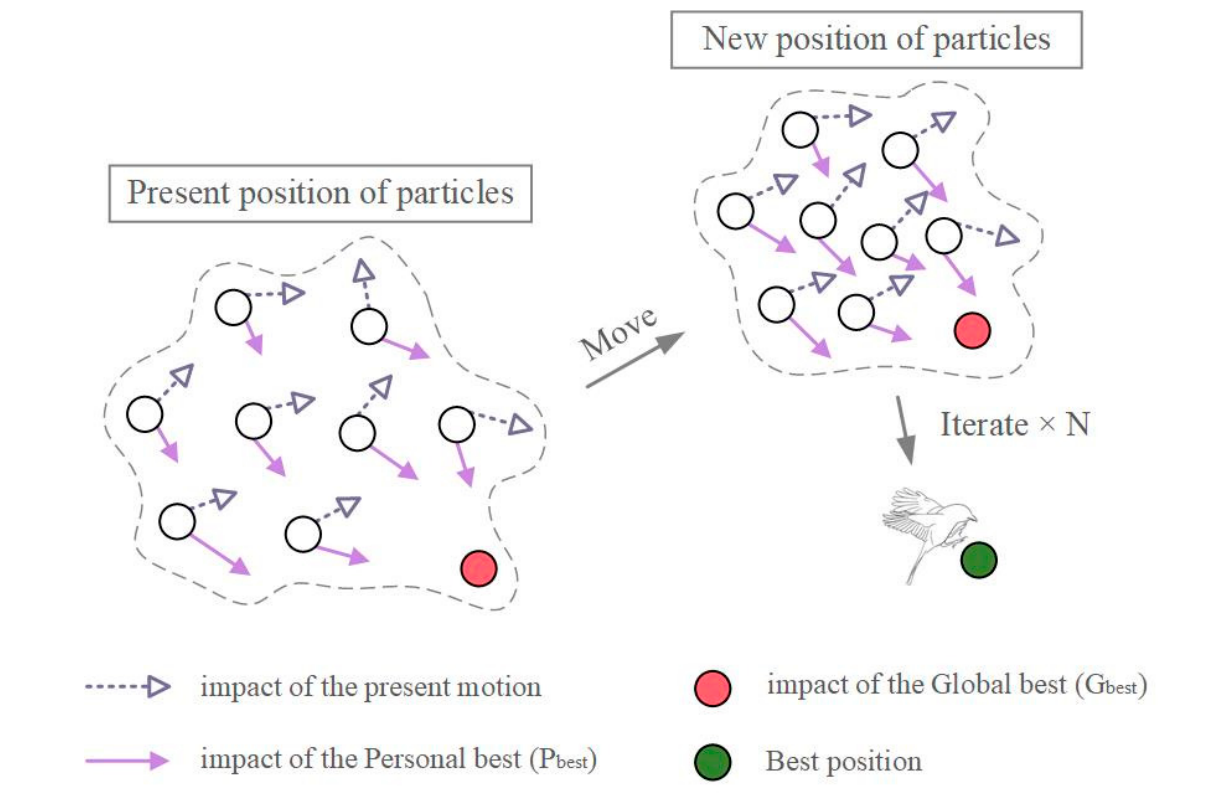
Figure 3. A typical architecture of PSO.